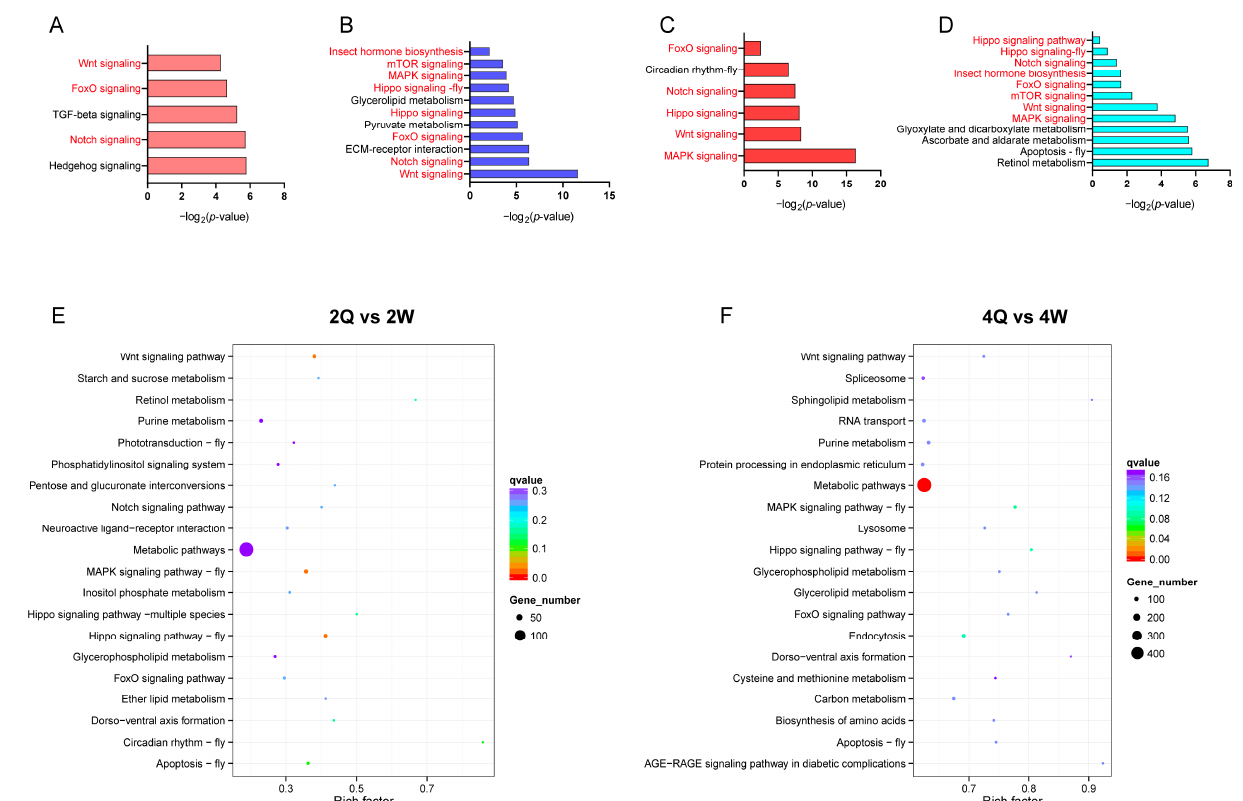
Figure 3. Negative log 2 p -values for the honey bee caste differentiation-related KEGG pathways that are enriched with unique H3K4me1-related genes in 2Q ( A ), 2W ( B ), 4Q ( C ), and 4W ( D ). Pathways marked in red font are pathways associated with caste differentiation, while black font is not. ( E ) KEGG pathway enrichment analysis of differentially H3K4me1 peak-related genes in 2Q vs. 2W. ( F ) KEGG pathway enrichment of differentially H3K4me1 peak-related genes in 4Q vs. 4W.